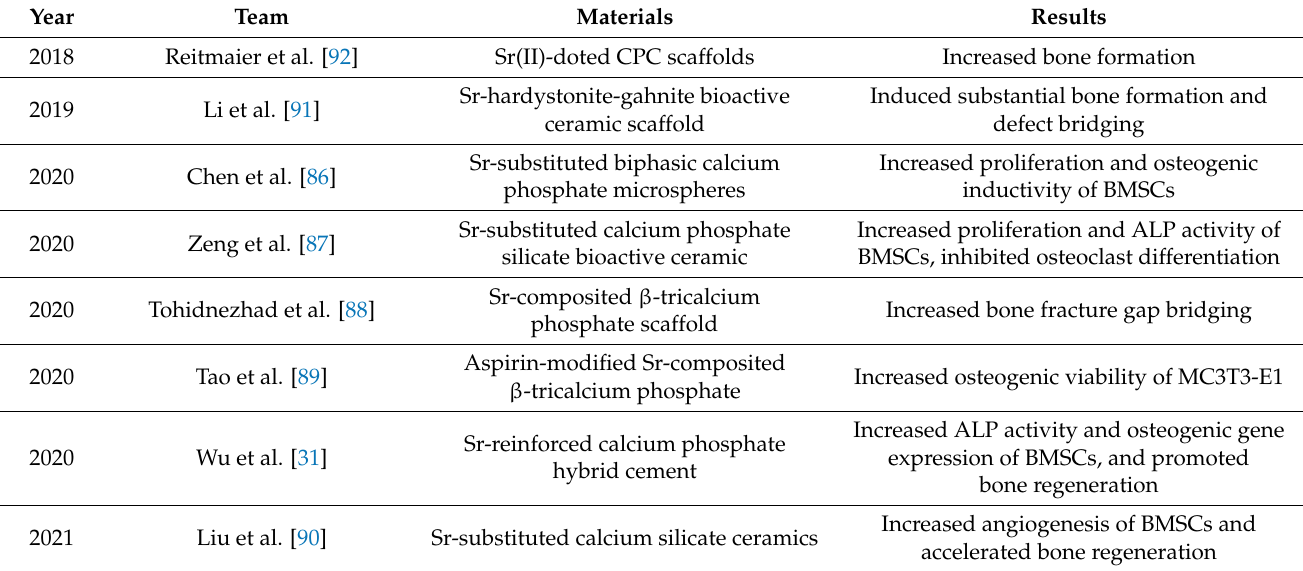
Table 3. The application of Sr compound with calcium phosphates ceramics and bone